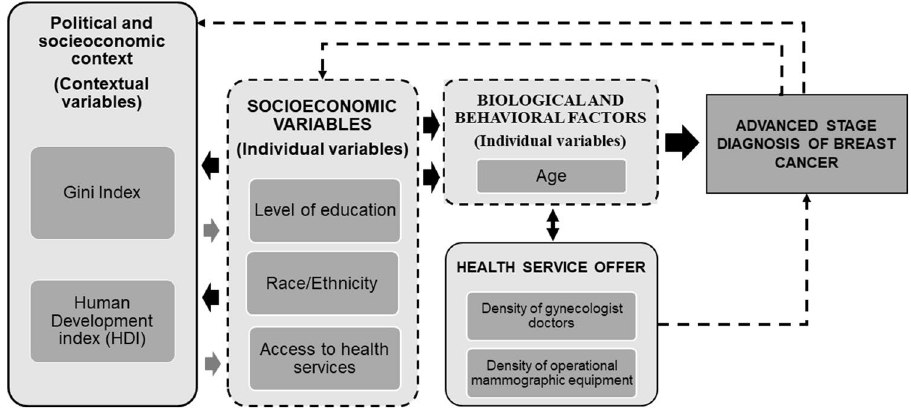
Figure 3. Theoretical model of the Social Determinants of Health related to advanced stage diagnosis of breast cancer in